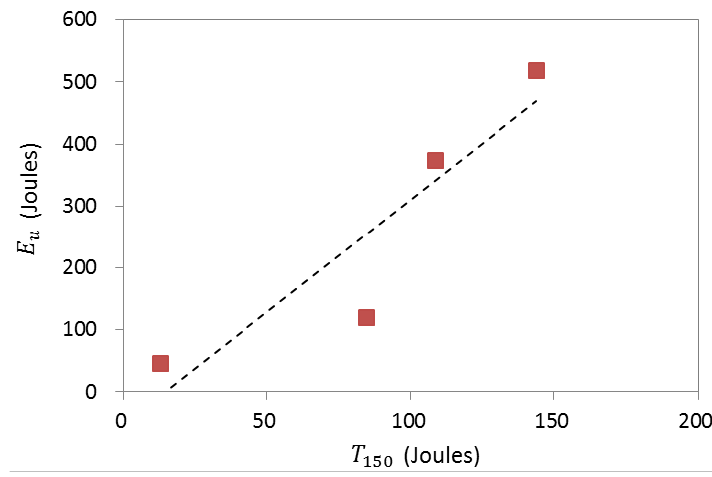
Figure 16. Relationship between the energy absorption capacity E u of the anchor and the energy absorption capacity T 150 of the beam.